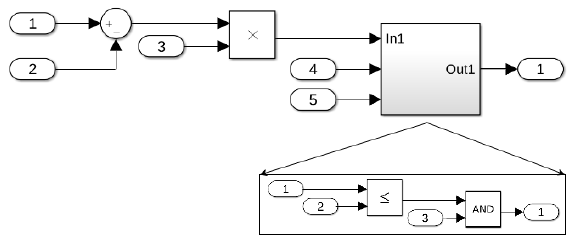
Figure 8. Simulink SubSystem.